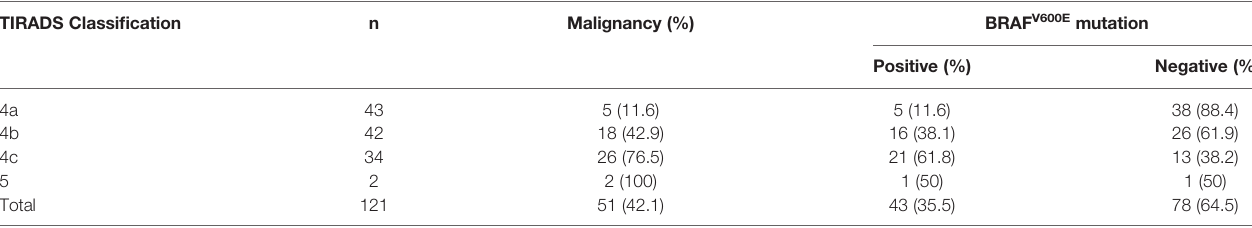
TABLE 5 | TIRADS classi fi cation and BRAF mutation status in 121 thyroid nodules with indeterminate cytology. TIRADS Classi fi